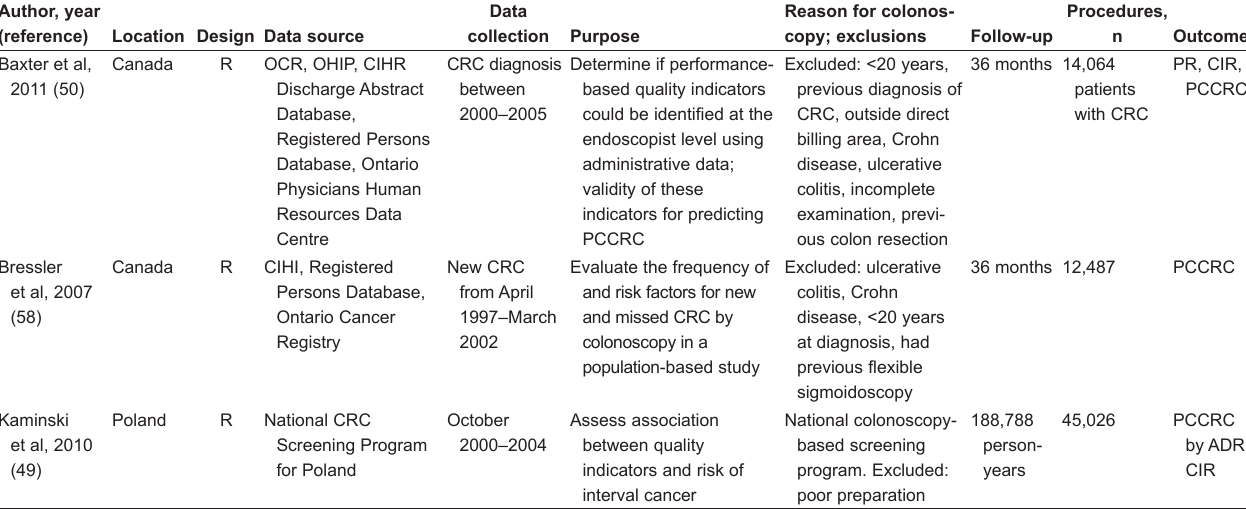
TAble 7 Study characteristics, postcolonoscopy colorectal cancer (PCCRC) Author, year